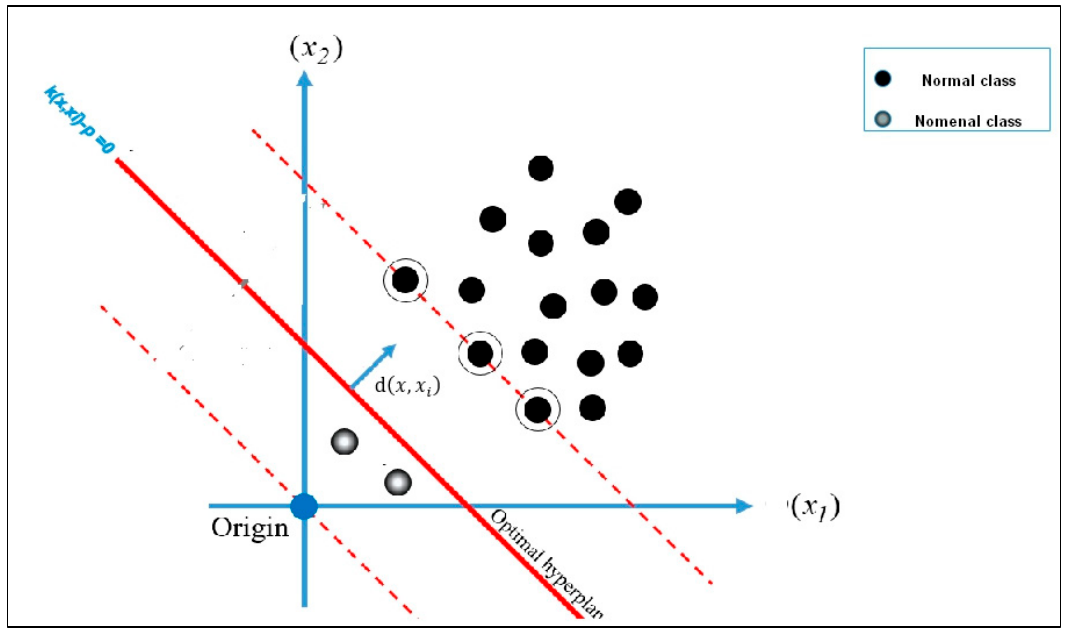
Figure 10. One ‐ class support vector machine. Figure 10. One-class support vector